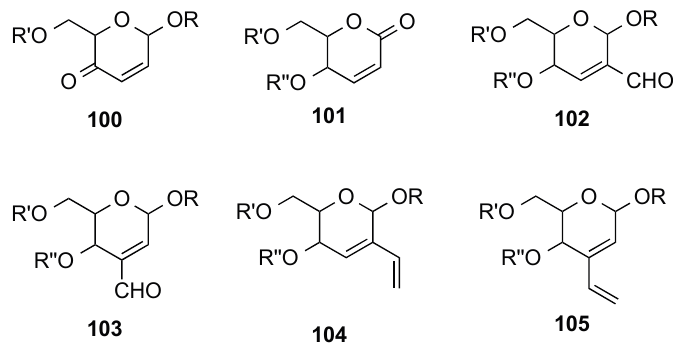
Figure 2. ∆ 2,3 - Unsaturated derivatives employed in cycloaddition reactions.